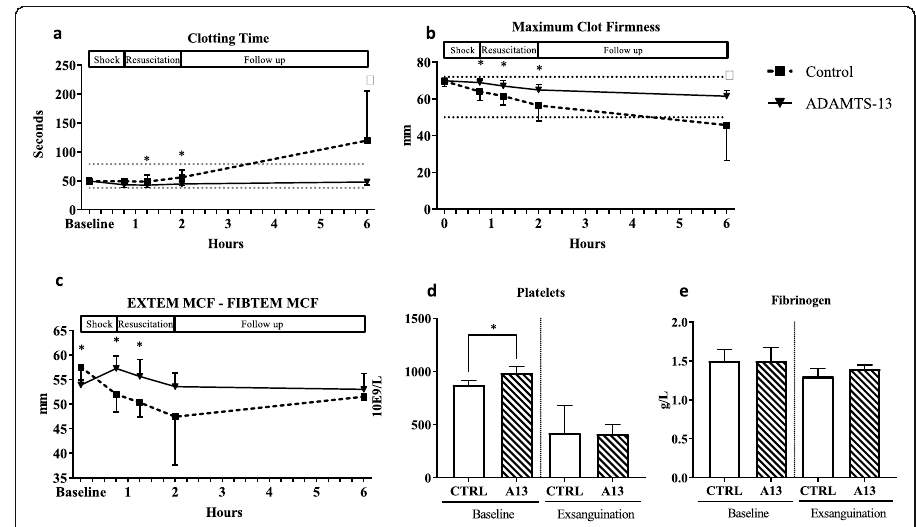
Fig. 2 Coagulation parameters. a Clotting time measured in EXTEM array over time. b Maximum clot firmness measured in EXTEM array over time. c Maximum clot firmness of EXTEM and FIBTEM assay subtracted as a reflection of platelet-driven coagulation. d Platelet counts at baseline and exsanguination. e Fibrinogen levels at baseline and exsanguination. ROTEM values presented as mean and standard deviation (SD). Reference values are according to human standards. Platelet count and fibrinogen levels are presented as median and interquartile ranges (IQR). * p <